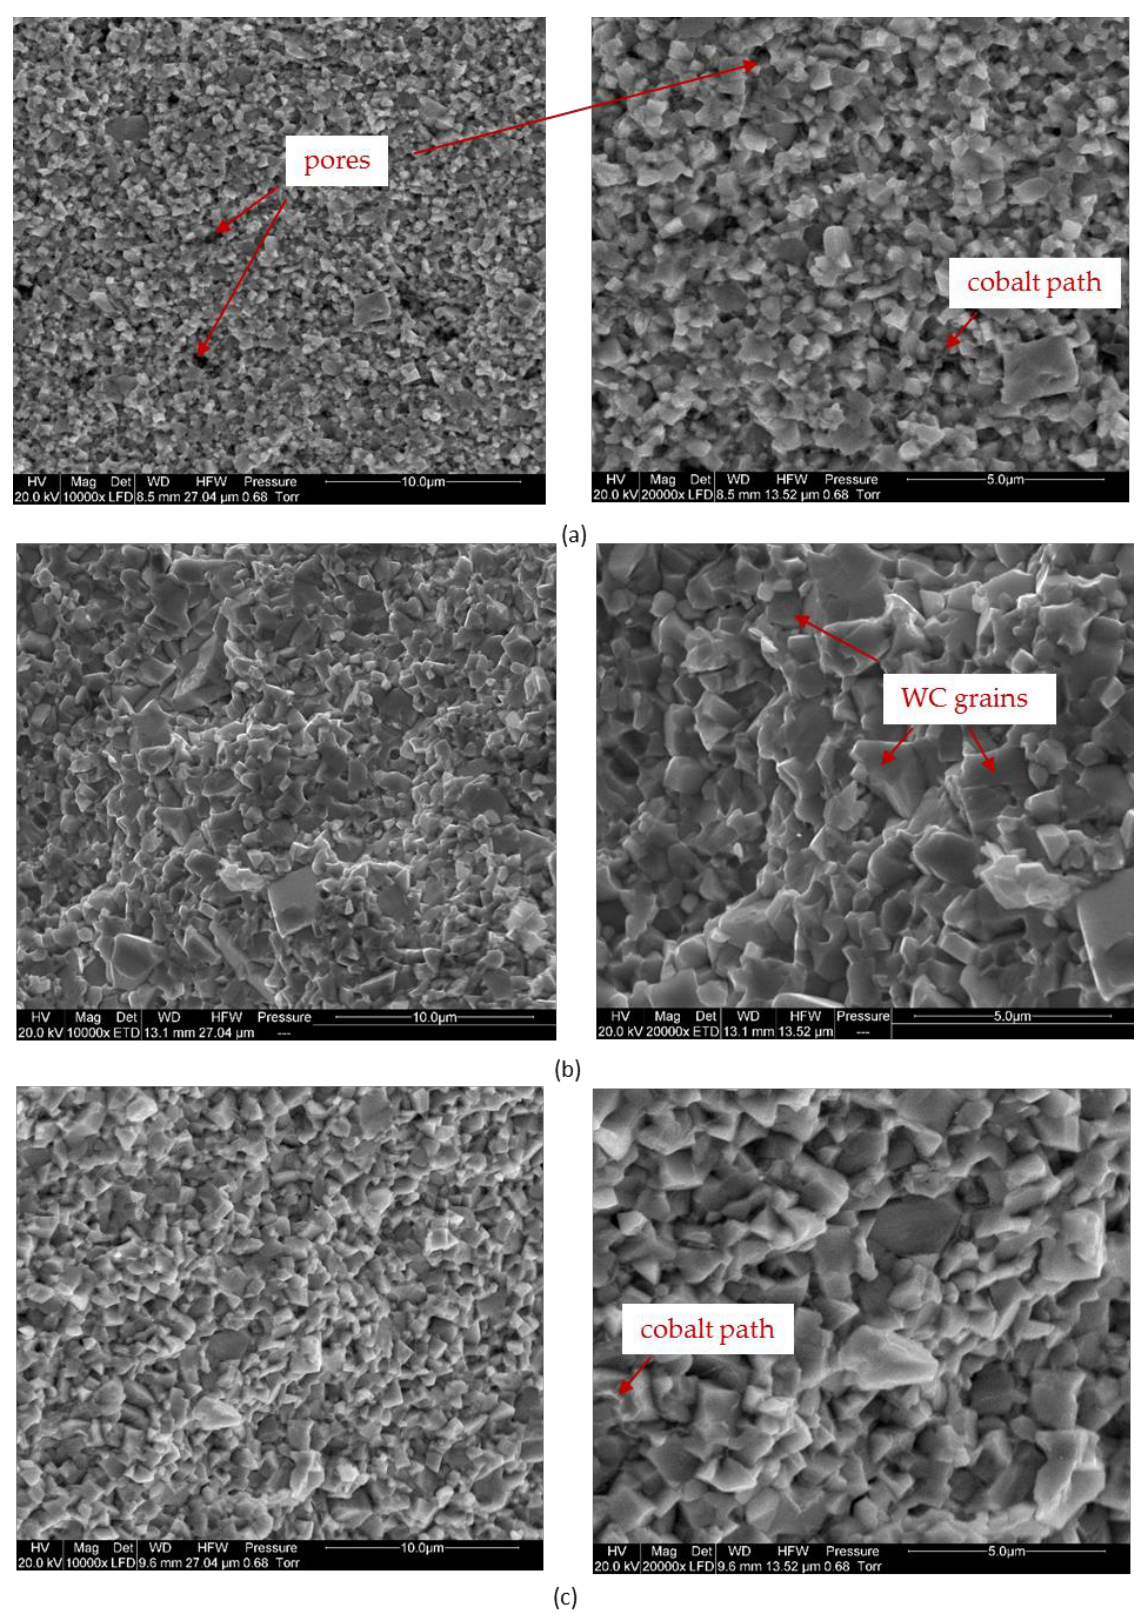
Figure 5. Microstructures of the composites: ( a ) submicron, ( b ) ultrafine, ( c ) commercial.